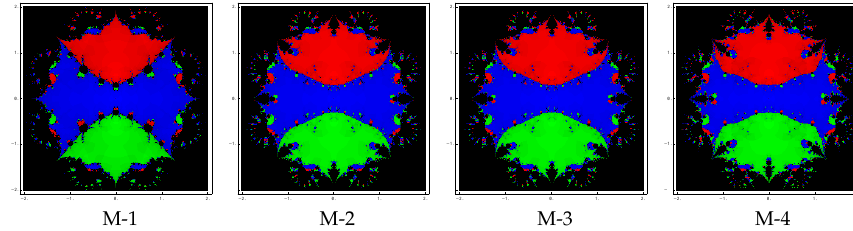
Figure 4. Basins of attraction by M-1–M-4 ( β = 0.01 ) for polynomial ψ 2 ( z )